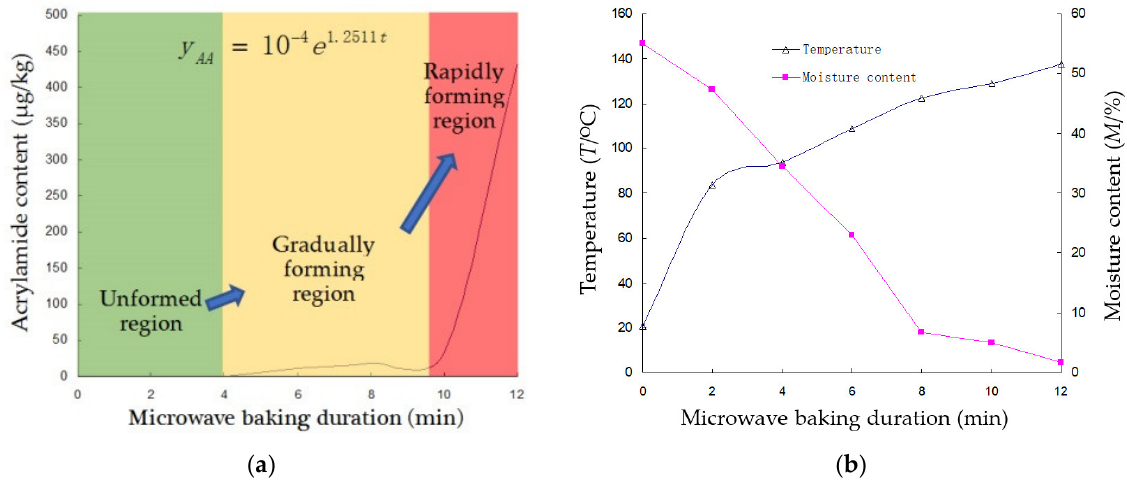
Figure 2. ( a ) Acrylamide content of adzuki beans under microwave baking. ( b ) Temperature and moisture content of adzuki beans after microwave baking.